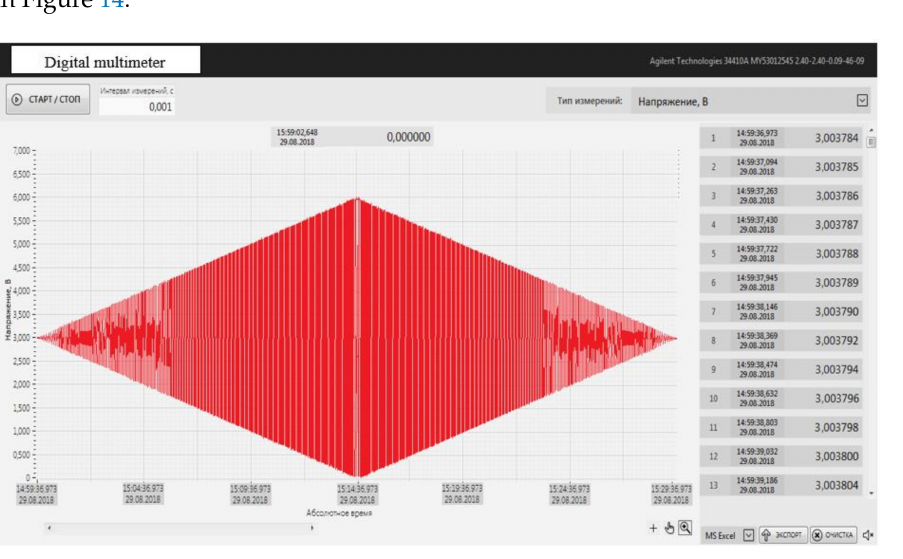
Figure 14. Data Physics LE-612 MST/DSA 10–40 k. Experimental dependences U = f ( g ) obtained on the vibrating test stand Data Physics LE-612 MST/DSA 10–40 k. The sensitivity of the conversion of FOAS is on average 3 mV/m/s 2